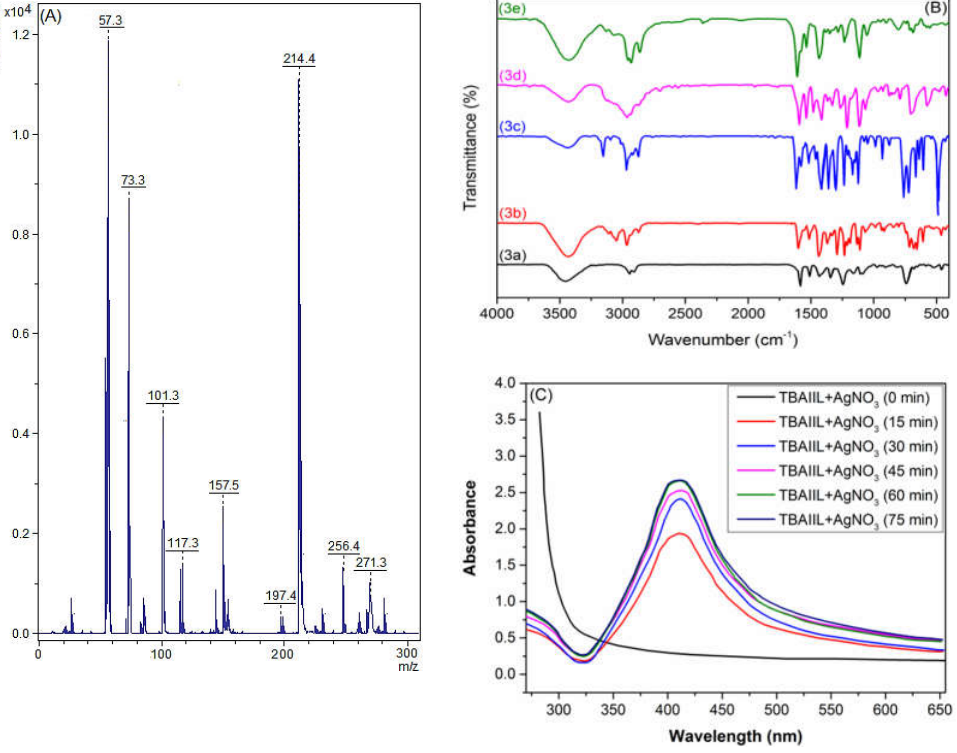
Figure 2. ( A ) A positive mode electrospray ionization mass spectra (ESI-MS (+ve)) of BAIIL ( 3f ); ( B ) FTIR spectra of the native BAIILs ( 3a–f ); and ( C ) UV-Vis spectrum AgNPs produced by BAIIL (3f) .